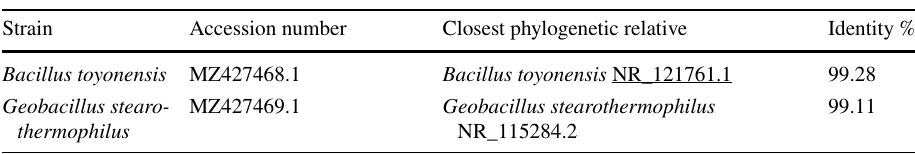
numbers, closest phylogenetic relative and identity percent of the isolated bacterial